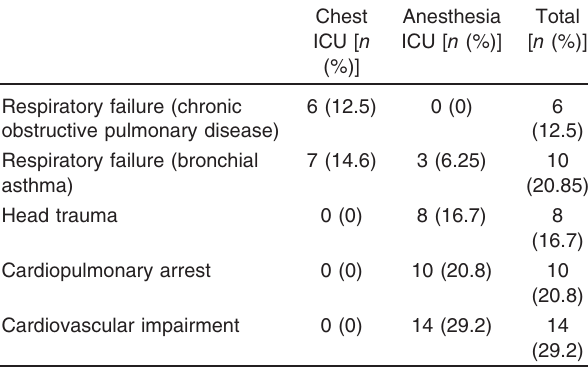
Table 2 Causes of admission in chest and anesthesia